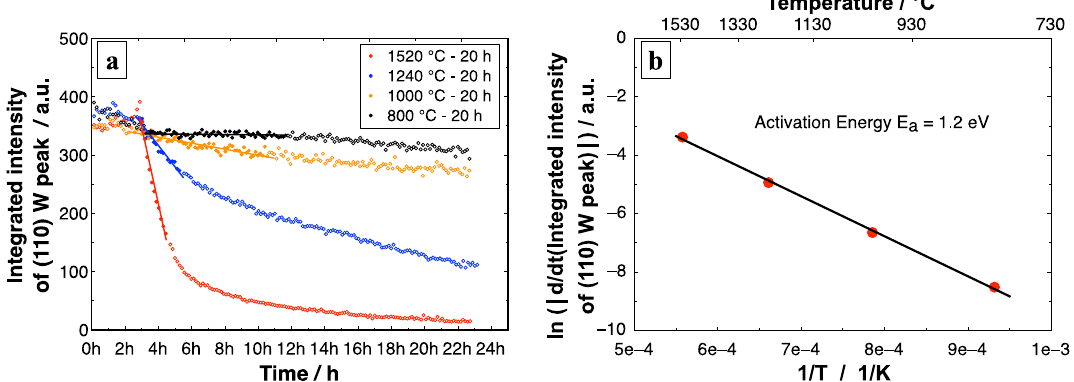
Figure 8.. ( a ) Integrated intensity of (110) W peak annealed at different temperatures for 20 h are shown. The slopes marked by the filled circles for each temperature are displayed as time derivatives in the logarithmic plot ( b ) in order to calculate the activation energy from its slope using a linear fit. ( b ) Arrhenius plot for the oxidation of W in the